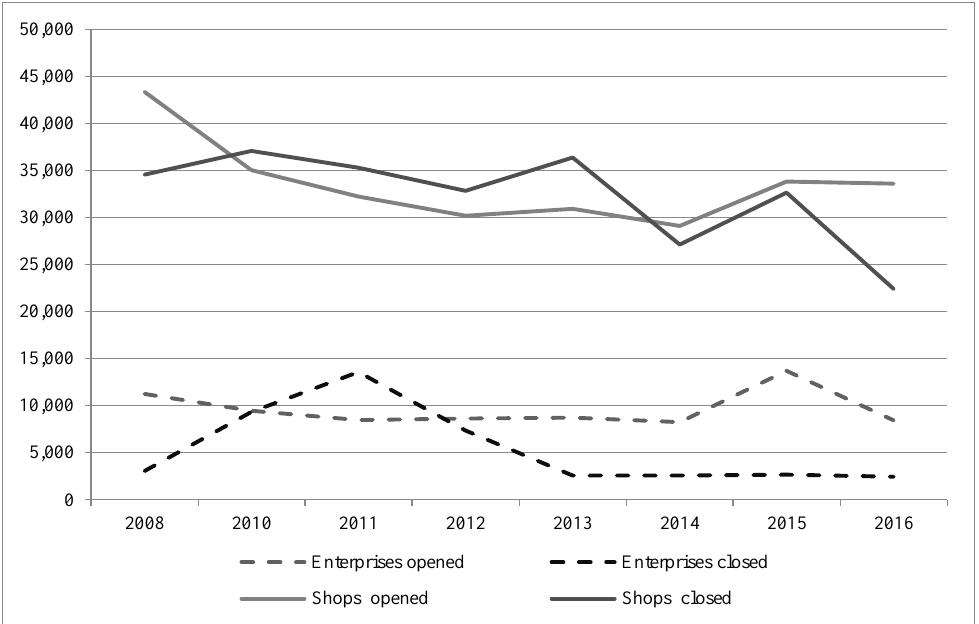
Figure 1. Serbia – Opened and closed companies and shops.